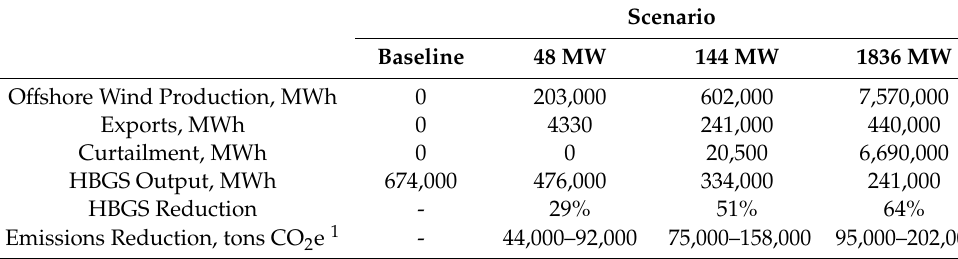
Table 6. Annual o ff shore wind electricity generation, end use, and HBGS operating